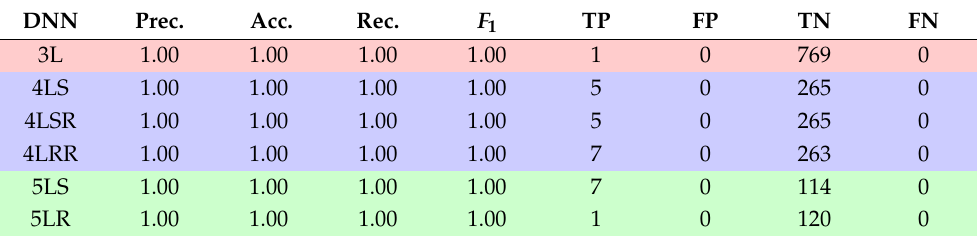
Table 2. Attack 2 detection results without measurement noise.